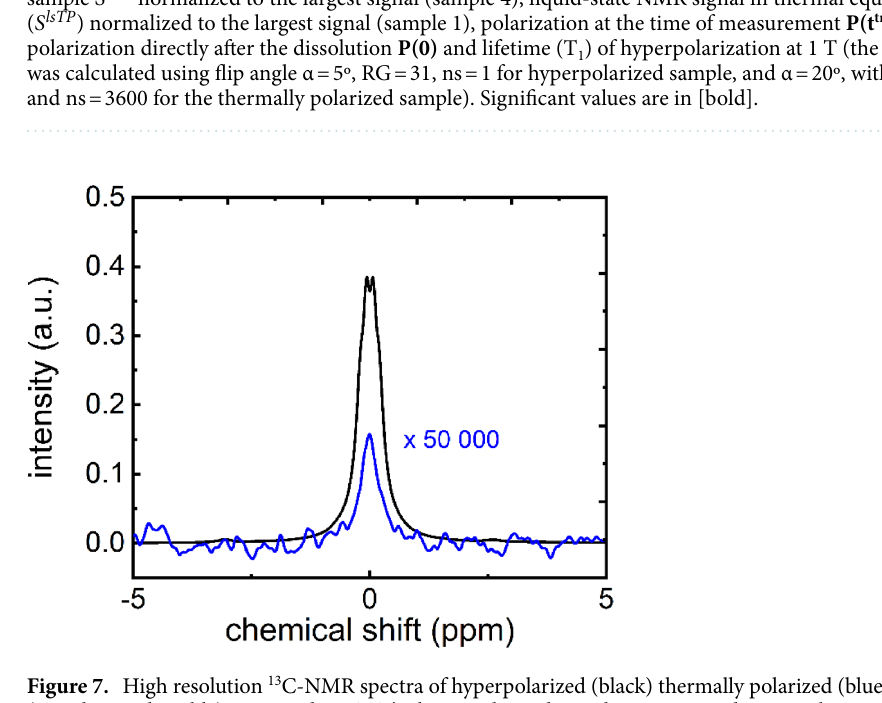
Figure 7. High resolution 13 C-NMR spectra of hyperpolarized (black) thermally polarized (blue) 1- 13 C-PA (sample 5 in the table) measured at 1 T. The hyperpolarized signal was measured in a single scan (NS DNP = 1) after approx. 17 s after dissolution ( α = 5°, p w = 3.05 µs, p a = − 5.6 dB). The thermally polarized signal was acquired adding 4 vol% Gd contrast agent ( α = 20°, p w = 12.20 µs, p a = − 5.6 dB, S DNP = 39.5 a.u.). The resulting signal enhancement to S DNP was 310 × 10 6 (Eq. 8), and the polarization = 43% (Eqs. 9, 10). The thermal spectrum measured was multiplied by 50,000 to fit in the